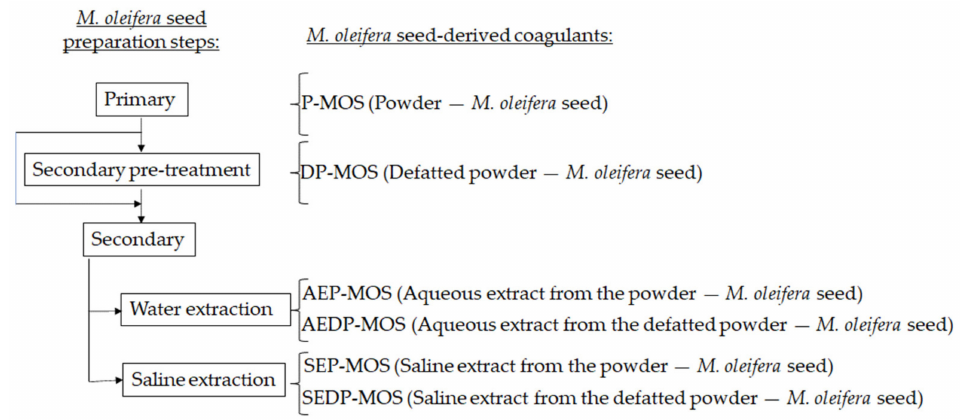
Figure 1. Processing steps for the production of M. oleifera seed-derived